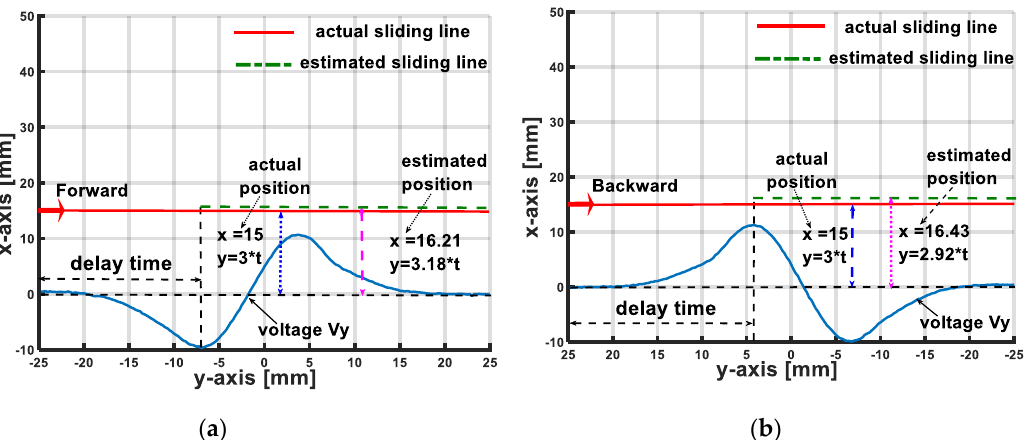
Figure 25. Comparison of actual sliding position and estimated position for Y-sliding cases. ( a ) Y-sliding case: forward direction. ( b ) Y-sliding case: backward direction.